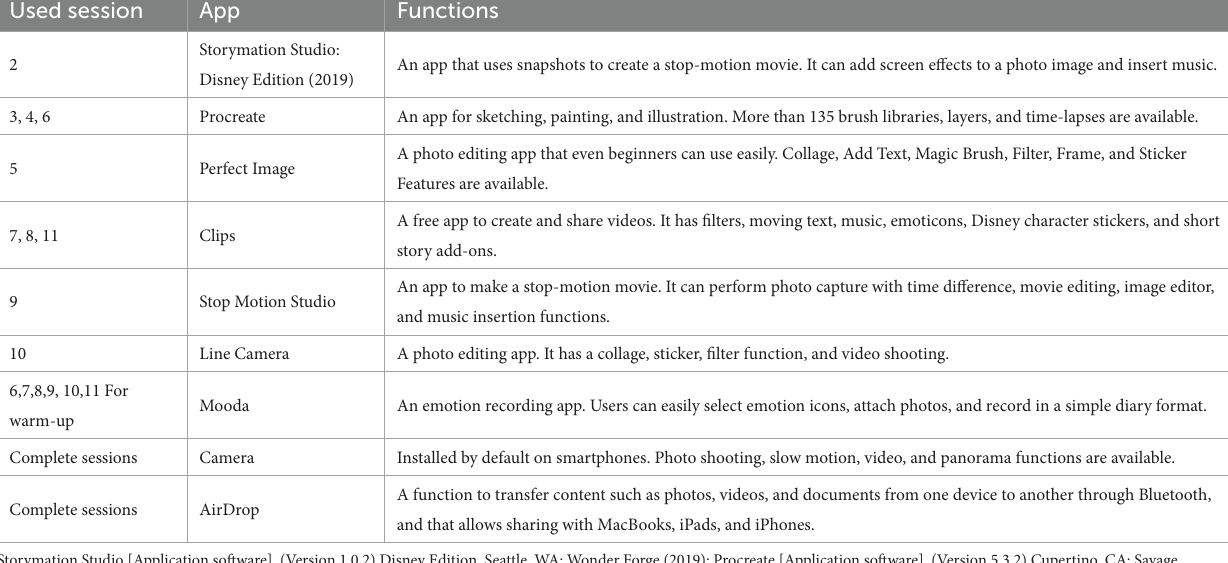
TABLE 3 Apps and functions used in digital art